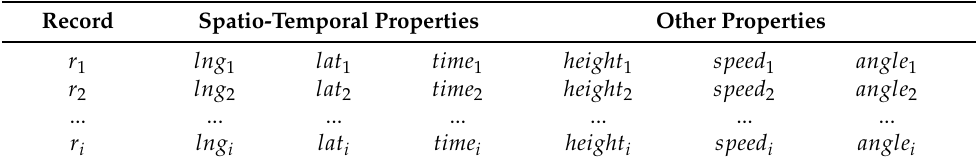
Table 2. An example of spatio-temporal record.